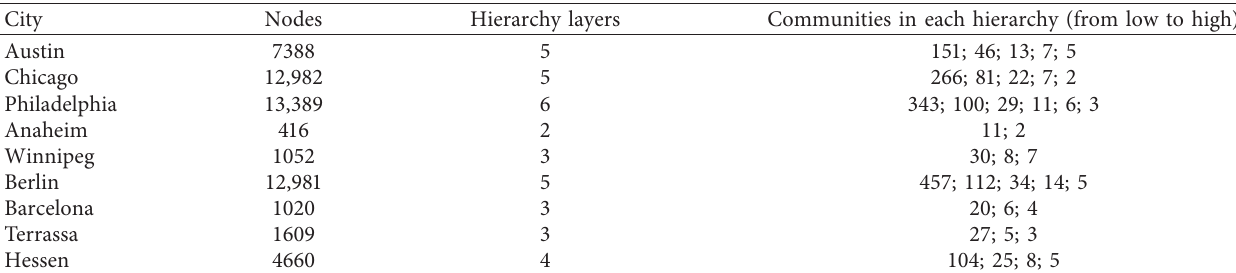
Figure 12: Schematic graphs of communities for nine urban road networks: (a) Anaheim; (b) Austin; (c) Barcelona; (d) Berlin; (e) Chicago; (f) Hessen; (g) Philadelphia; (h) Terrassa; (i) Table 7: Structure of hierarchy and communities in each hierarchical layer for nine URNs.